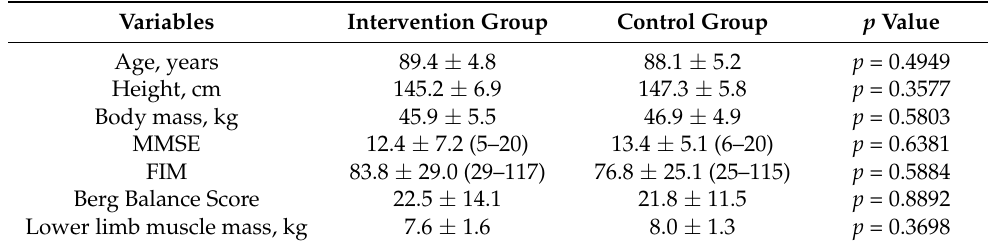
Table 1. Characteristics of subjects.